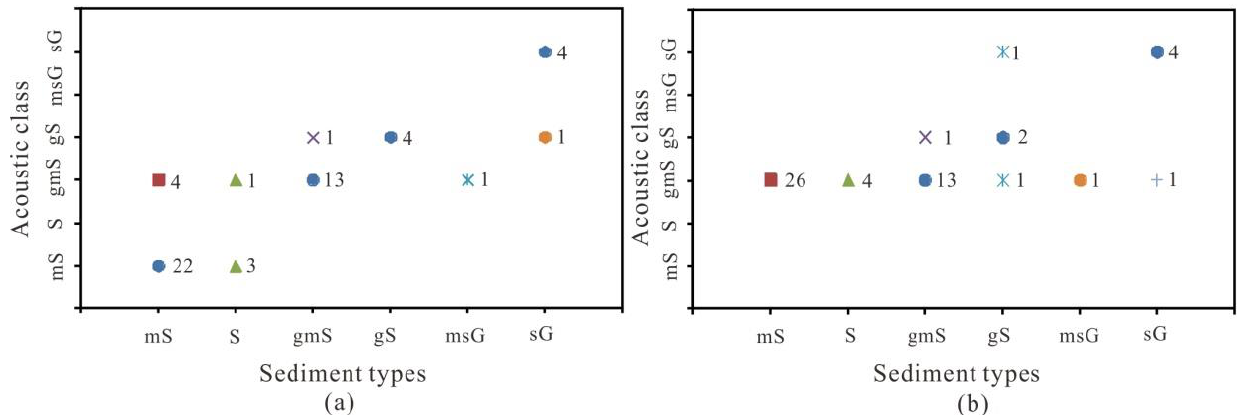
Figure 6. The correlation between acoustic class and measured sediment types at BP_A. ( a ) BM and BS were set as the explanatory variables, and ( b ) BS was set as the explanatory variables. The blue dots indicate correct matches between acoustic class and measured sediment types, other colored symbols indicate wrong matches, and the Arabic number indicates the number of matches.